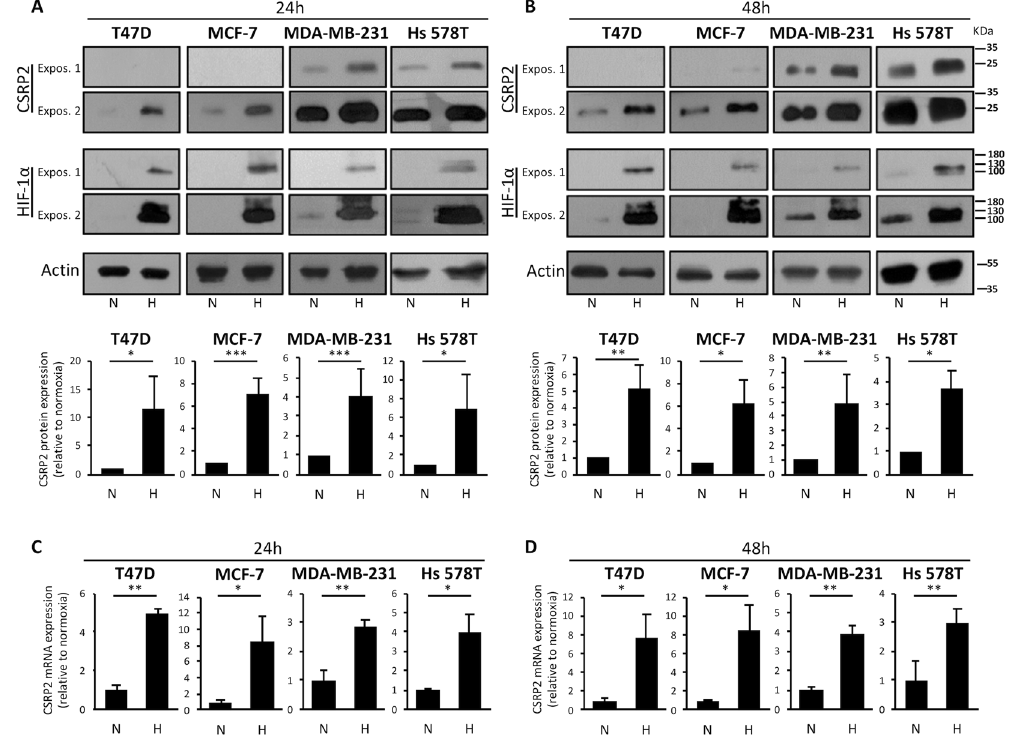
Figure 1. Hypoxia upregulates CSRP2 protein and transcript levels in human breast cancer cells. ( A , B ) Western blot analysis of CSRP2 and HIF-1 α protein levels in epithelial (T47D, MCF-7) and mesenchymal (MDA-MB-231, HS-578T) human breast cancer cells cultured for 24 h ( A ) or 48 h ( B ) in normoxic (N) or hypoxic (H) conditions. Short and long exposures for CSRP2 and HIF-1 α blots are shown to better appreciate the differences between the cell lines (“Expos. 1” and “2”, respectively). After quantification, protein levels were normalized to β -actin levels and CSRP2 protein levels in hypoxia were expressed as fold of normoxic control (set to 1). The lower charts indicate the mean ± s.e. calculated from at least 4 independent experiments. ( C , D ) qRT-PCR analysis of CSRP2 transcript levels in the same four cell lines after 24 h ( C ) or 48 h ( D ) incubation in normoxic (N) or hypoxic (H) conditions. Results are expressed as CSRP2 transcript levels in hypoxia relative to normoxic control (set to 1). Shown are the mean ± s.e. calculated from 3 ( C ) and 4 ( D ) independent experiments. * p < 0.05; ** p < 0.01; *** p <